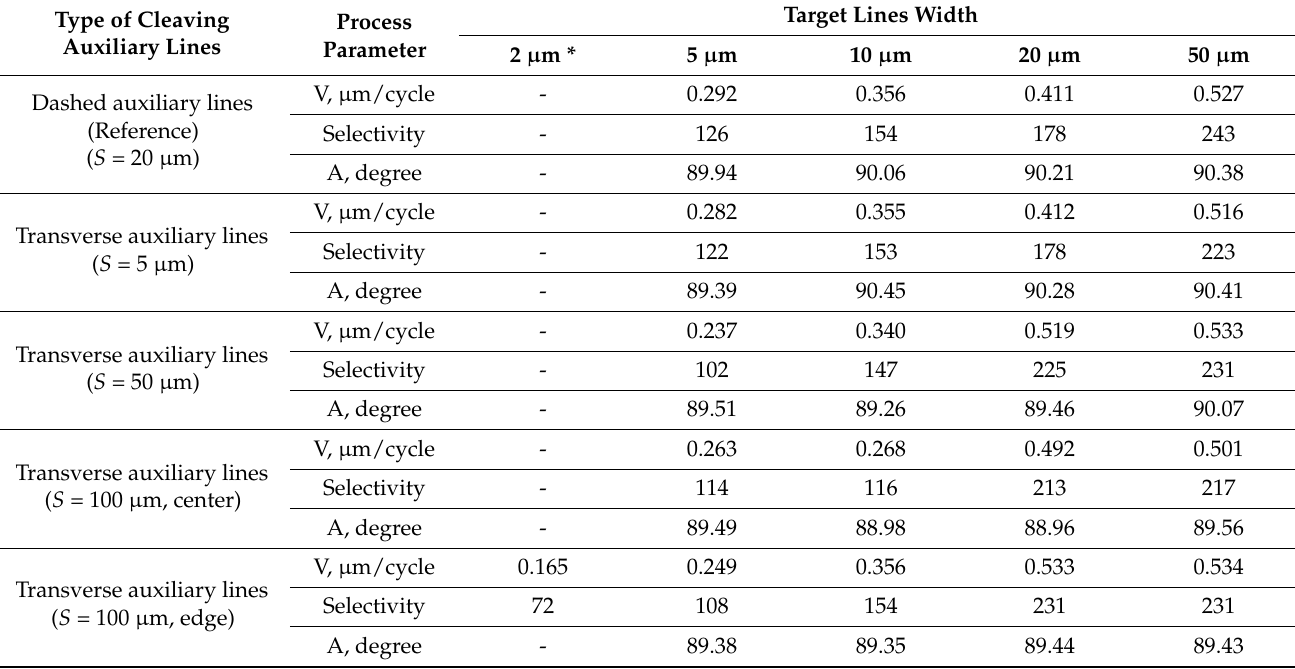
Table 3. Deep etching experimental results for target microstructures with aspect ratio W:D = 1:1.